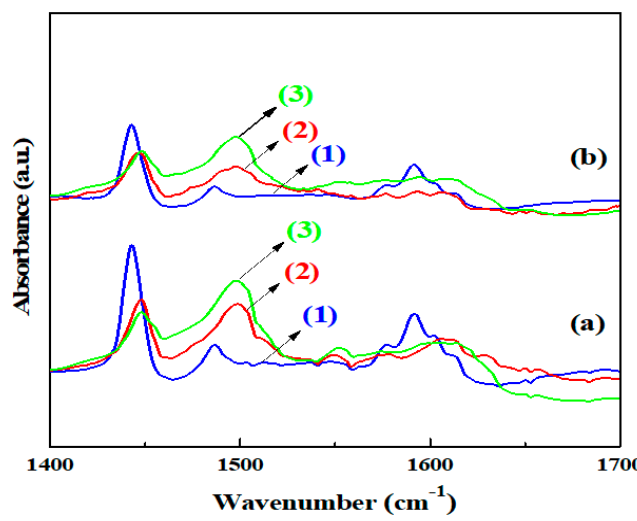
Figure 5. FTIR spectra of pyridine adsorbed of the samples: ( a ) Cu-Pd/ γ -Al 2 O 3 measured after heating